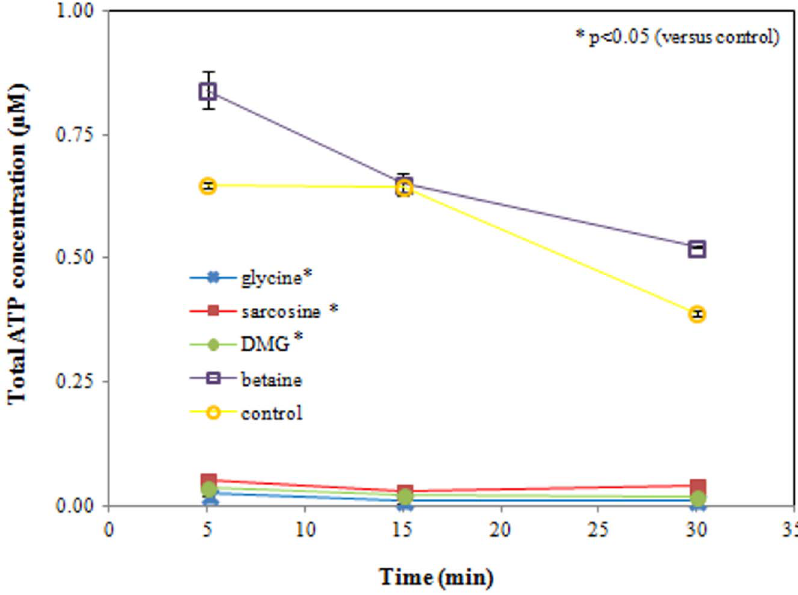
Figure 9. Total ATP concentration of E.coli . ETEC were exposed to glycine, sarcosine, DMG, betaine (50 mM, pH 9.5) and sterile PBS (control, pH 9.5) for up to 30 min. Already after 5 min of incubation, a significant (p , 0.0005) loss of ATP occurs in the bacterial populations exposed to glycine, sarcosine and DMG, compared to the control and betaine sample. Data are expressed as means 6 SD of triplicate experiments.